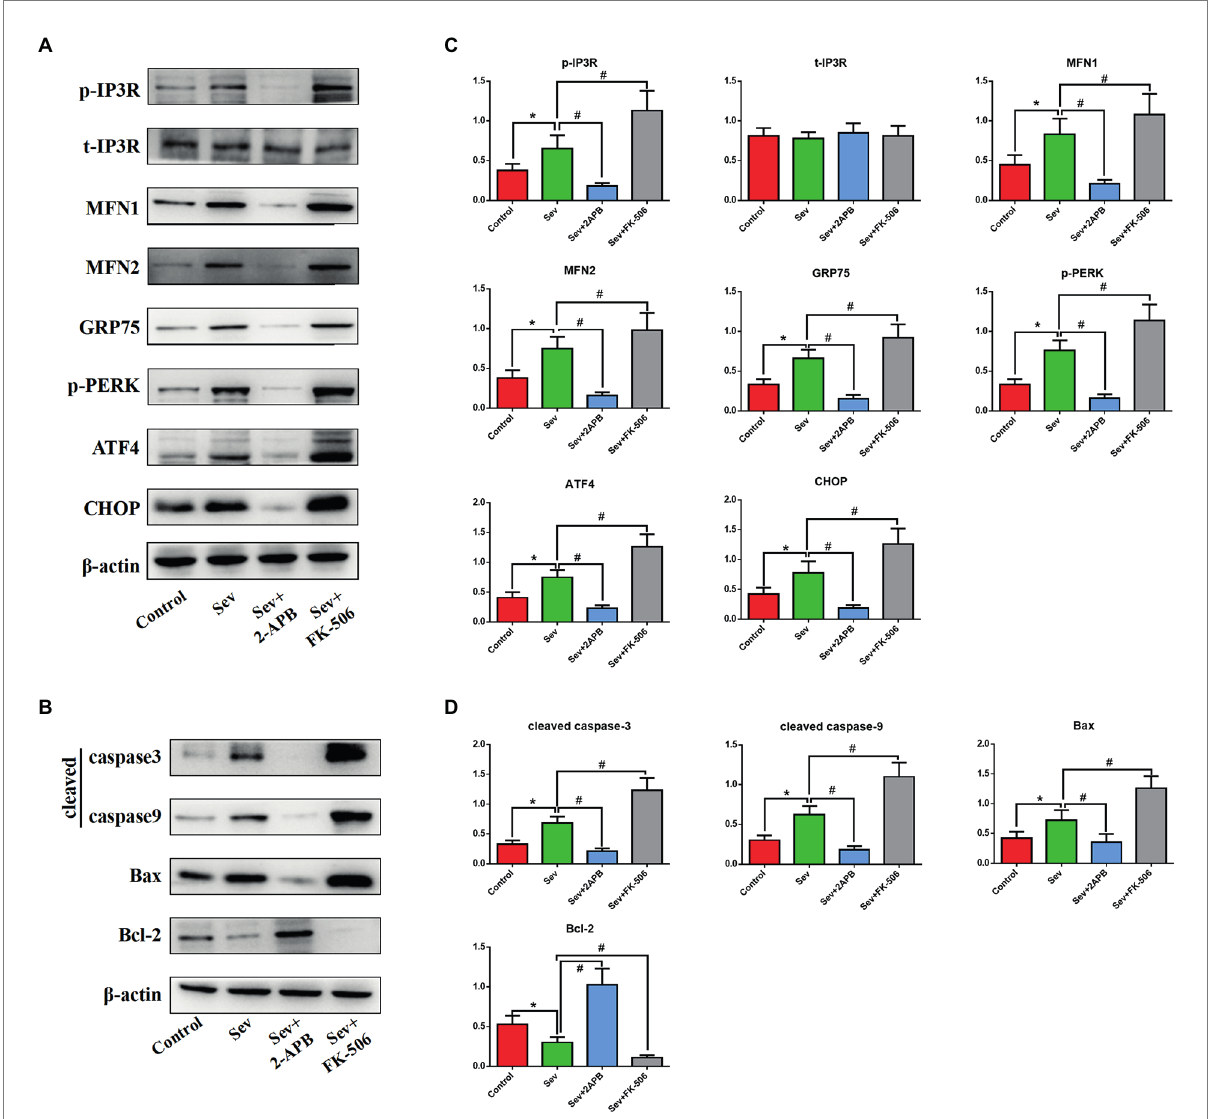
FIGURE 9 Sevoflurane upregulates IP3R and activates endoplasmic reticulum stress and the caspase-related apoptotic pathway in isolated hippocampal neurons. (A) Representative western blot of p-IP3R, t-IP3R, MFN1, MFN2, GRP75, p-PERK, ATF4, CHOP, cleaved caspase-9, cleaved caspase-3, Bcl- 2, and Bax. (B) Representative histogram of the relative expression of p-IP3R, t-IP3R, MFN1, MFN2, GRP75, p-PERK, ATF4, CHOP, cleaved caspase-9, cleaved caspase-3, Bcl-2 and Bax. Data are presented as mean ± SD ( n = 5 in each group). Compared with the Control group, * p < 0.05; compared with the Sev group, # p <